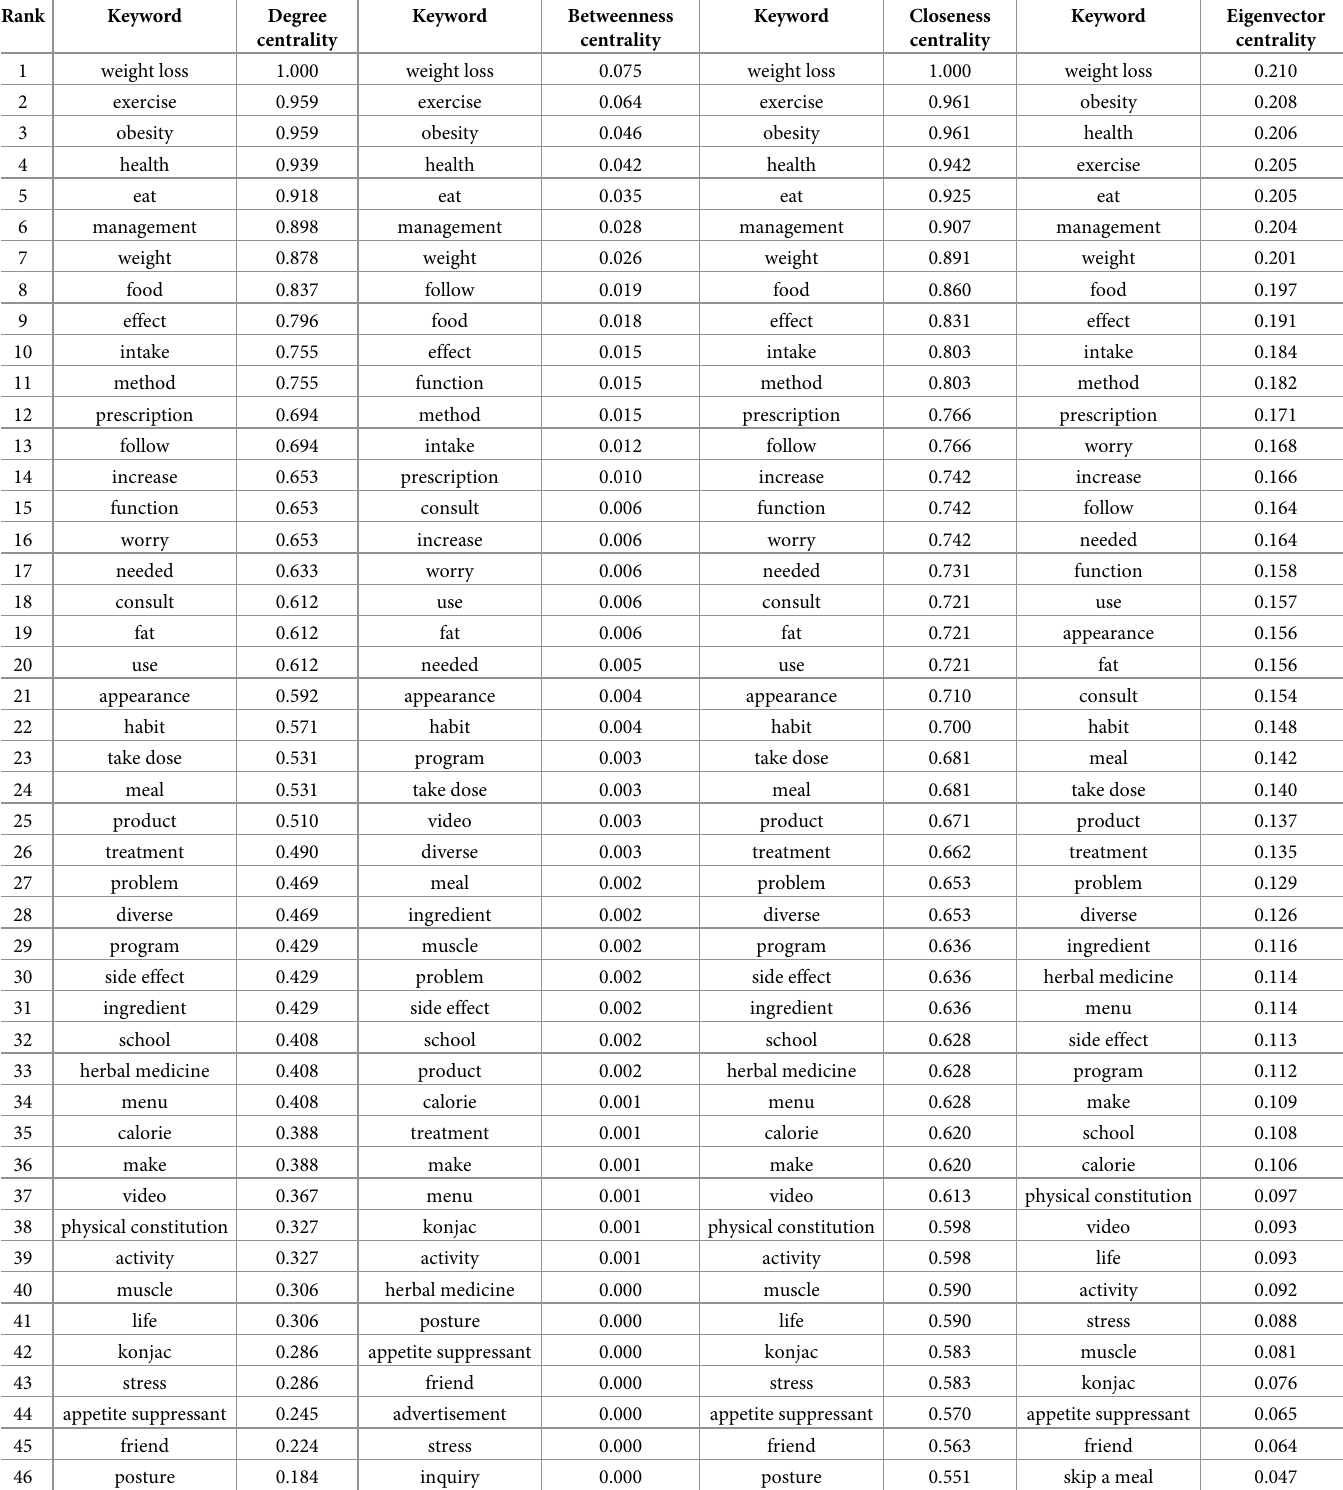
Table 4. Centralities of keywords related to adolescents’ diets from Blog